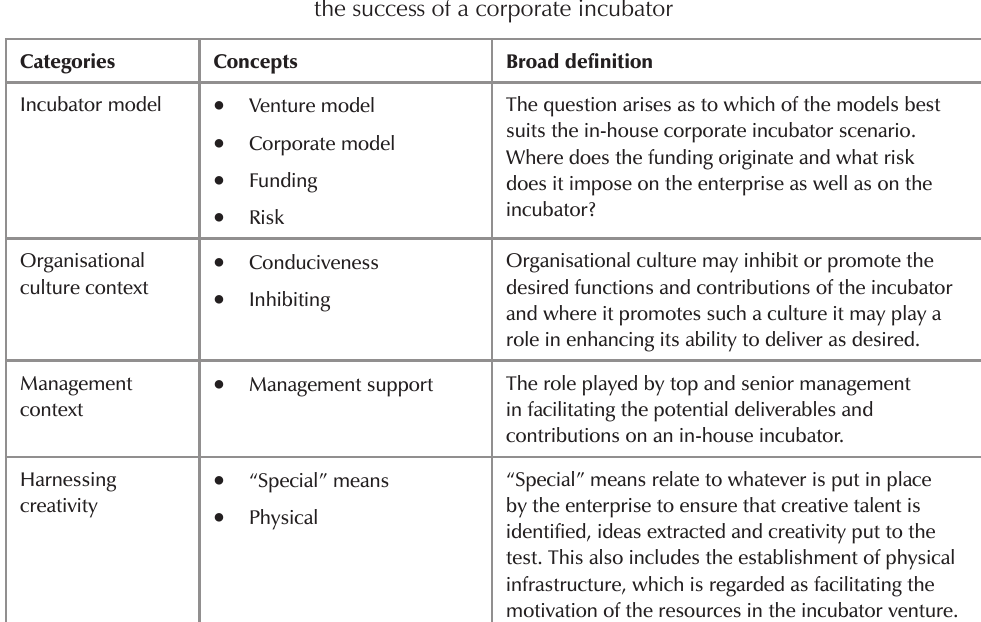
Categories, concepts, and broad definitions: The attributes necessary